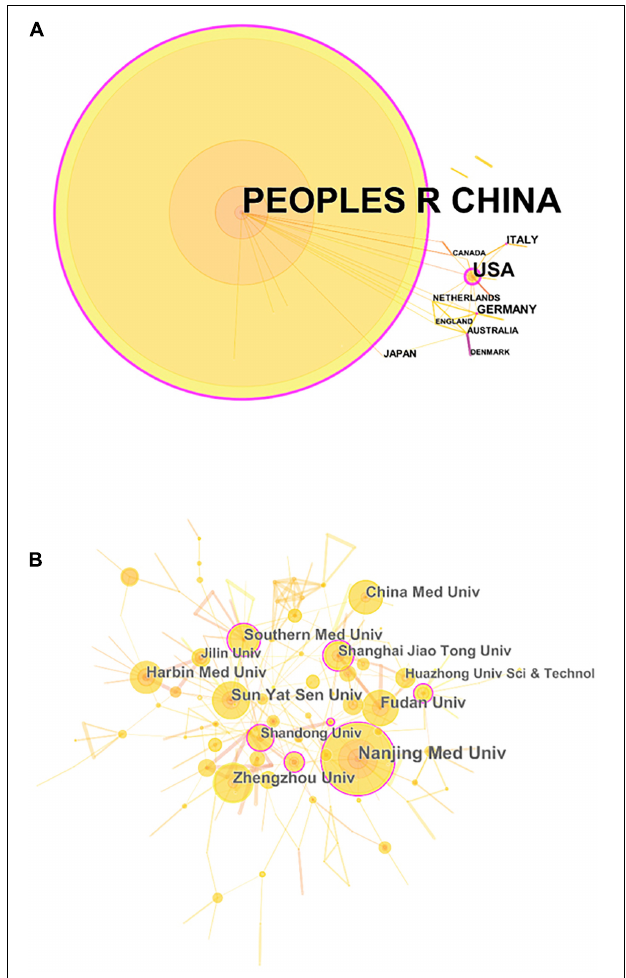
FIGURE 3 | The analysis of countries/regions and institutions. (A) Network map of countries/regions engaged in research on the crosstalk between microRNAs and circular RNAs; (B) Network map of institutions engaged in research on the crosstalk between microRNAs and circular